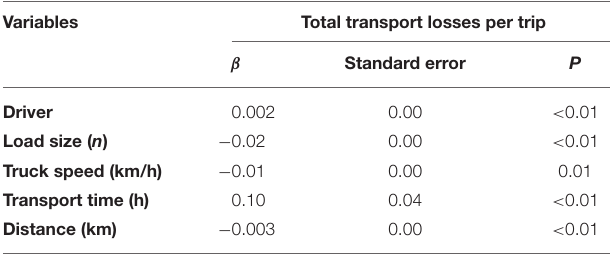
TABLE 4 | Relationship between total transport losses (DOA + NA) per trip and transport variables*.